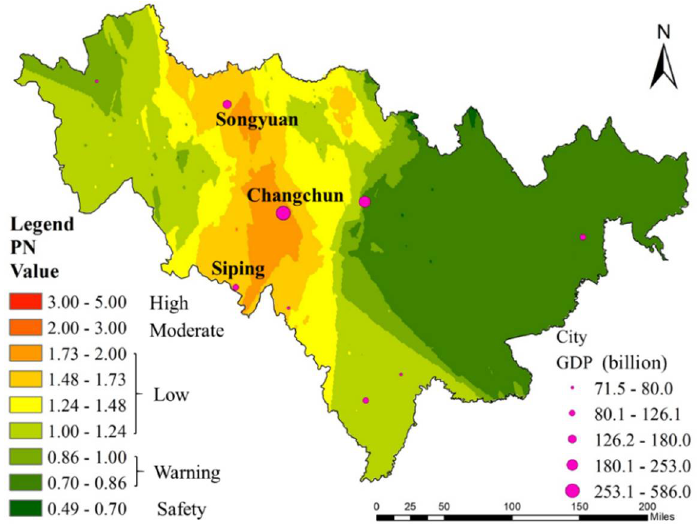
Figure 4. Distribution of PN in Jilin Province farmland.